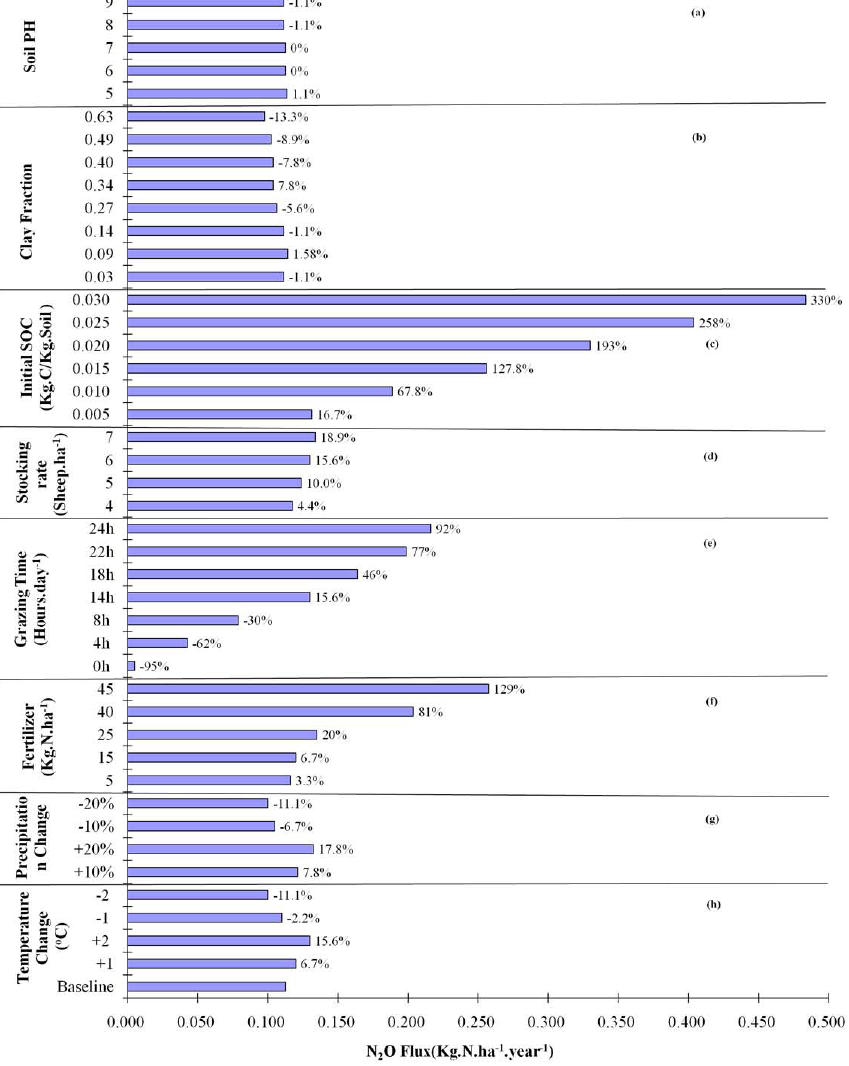
Fig. 3. Effect of changing a single factor of soil, management and climate on sensitivity analysis